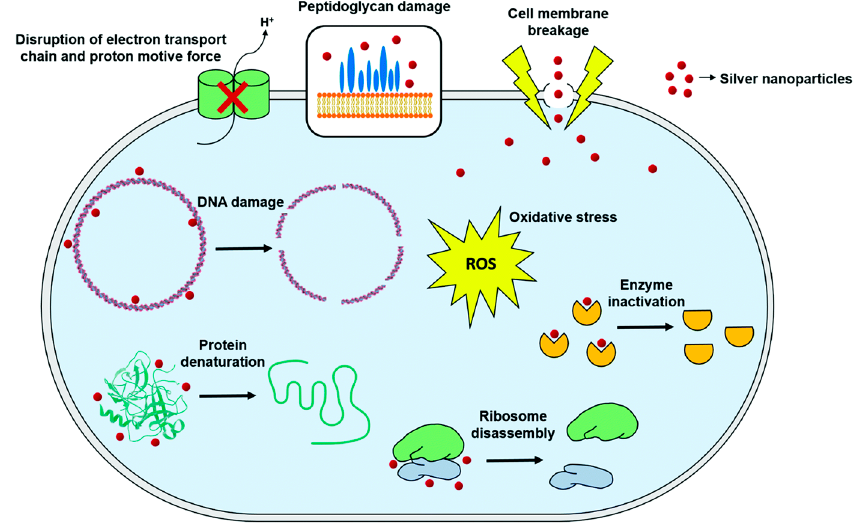
Figure 2. Overview of the antimicrobial action mechanisms of silver NPs (used with permission from [135]). from